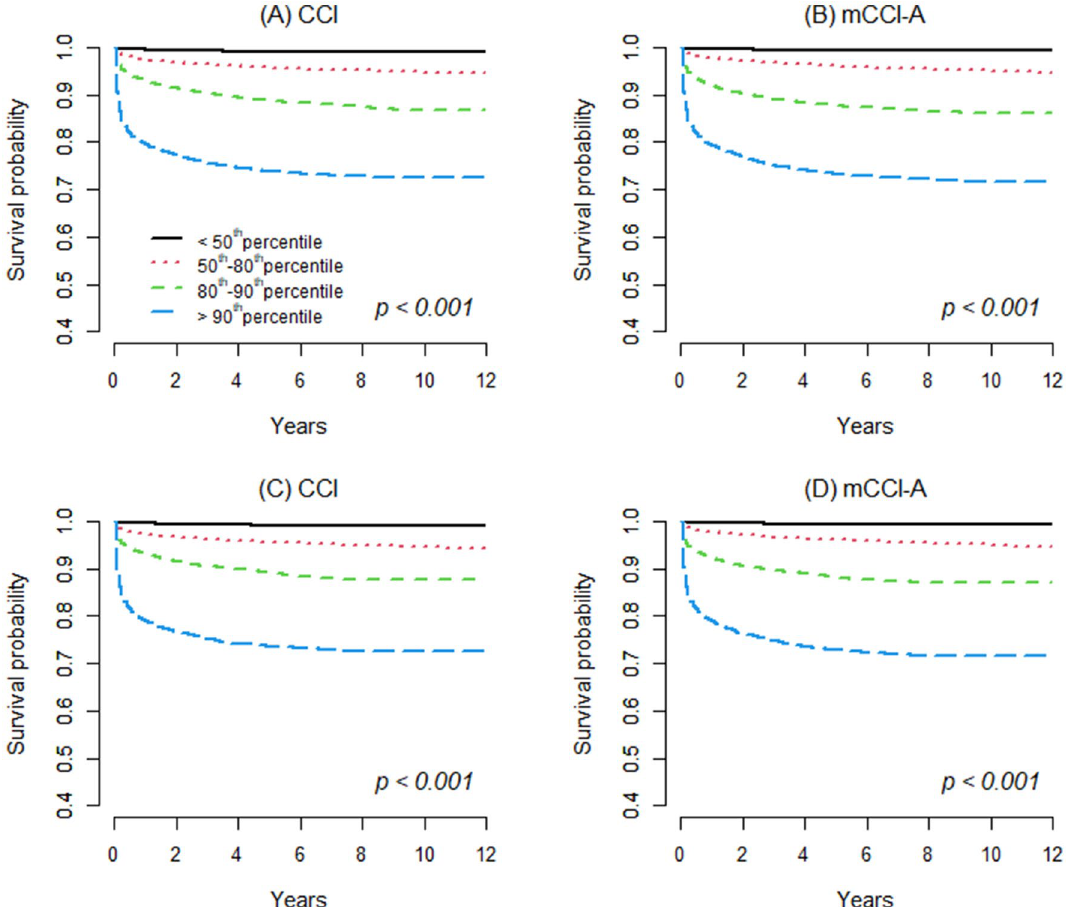
Figure 3. Survival curves obtained using the Kaplan–Meier method in the development and validation cohorts differentiated by 4 risk groups for CCI and mCCI-A. ( A ) Survival curves in the development cohort for CCI, ( B ) Survival curves in the development cohort for mCCI-A, ( C ) Survival curves in the validation cohort for CCI, ( D ) Survival curves in the validation cohort for mCCI-A. CCI in development cohort, < 50th percentile (n = 220,258, scores 0–1); 50th–80th percentile (n = 103,849, scores 2–3); 80th–90th percentile (n = 40,558, scores 4–5) and > 90th percentile (n = 34,837, score ≥ 6). mCCI-A in the development cohort, < 50th percentile (n = 215,768, scores 0–1); 50th–80th percentile (n = 113,413, scores 2–4); 80th–90th percentile (n = 31,535, scores 5–6) and > 90th percentile (n = 38,786, score ≥ 7). CCI in the validation cohort, < 50th percentile (n = 94,378, scores 0–1); 50th–80th percentile (n = 44,517, scores 2–3); 80th–90th percentile (n = 17,467, scores 4–5) and > 90th percentile (n = 14,852, score ≥ 6). mCCI-A in the validation cohort, < 50th percentile (n = 92,507, scores 0–1); 50th–80th percentile (n = 48,490, scores 2–4); 80th–90th percentile (n = 13,626, scores 5–6) and > 90th percentile (n = 16,591, score ≥ 7). CCI, Charlson Comorbidity Index; mCCI-A, modified version of the Charlson Comorbidity Index for Asian